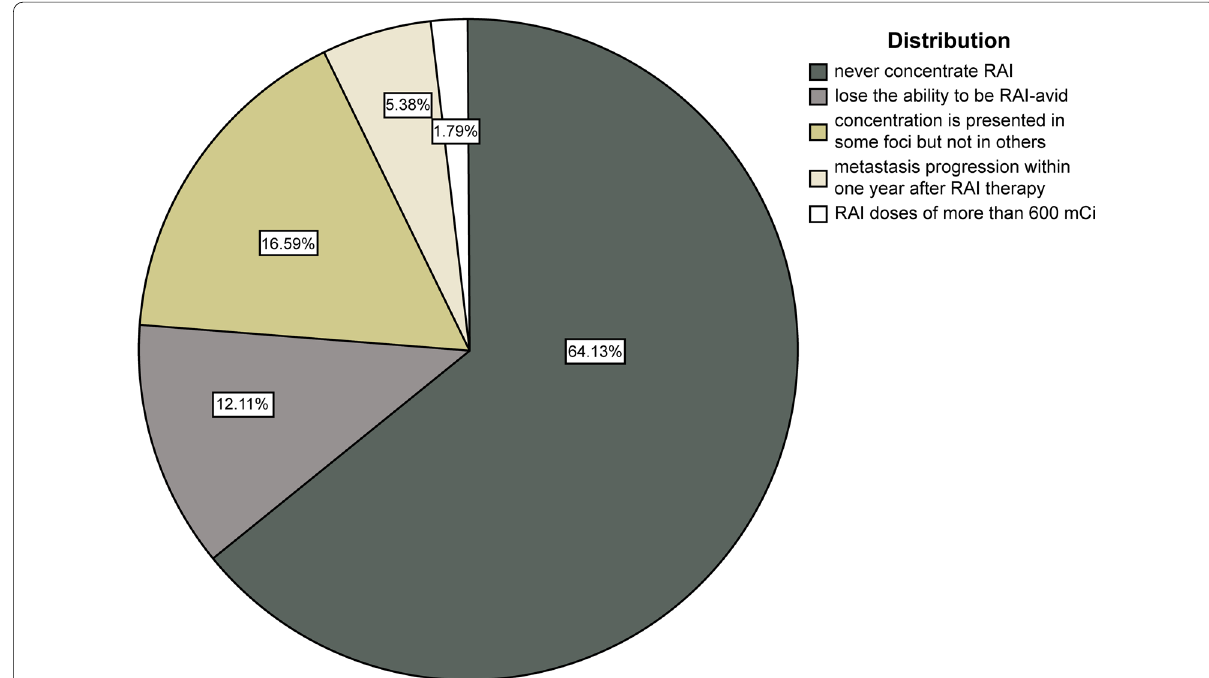
Fig. 1 Distribution of RR-DTC. 1. The foci never concentrate RAI; 2. Despite previous evidence of RAI concentration, the foci lose the ability to be RAI-avid; 3. Despite the significant concentration of RAI, concentration is presented in some foci but not in others; 4. Metastasis progression within 1 year after RAI therapy; 5. RAI doses of > 600 mCi. Patients who meet the characteristics of types 1–4 are defined as having the corresponding RR-DTC type, and those who do not meet the criteria of types 1–4 are defined as having RR-DTC type 5. RAI, radioactive iodine; RR-DTC, radioiodine